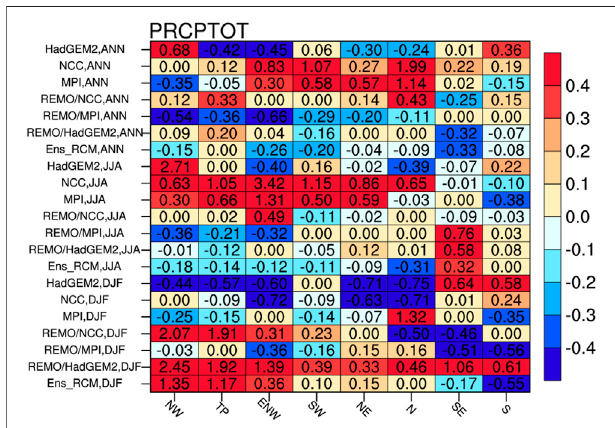
FIGURE 2 | The relative root mean square error (RMSE ’ ) of the annual (ANN), summer (JJA) and winter (DJF) precipitation in eight sub-regions from the GCMs, the RCM simulations and the RCM ensemble. Negative values indicate better